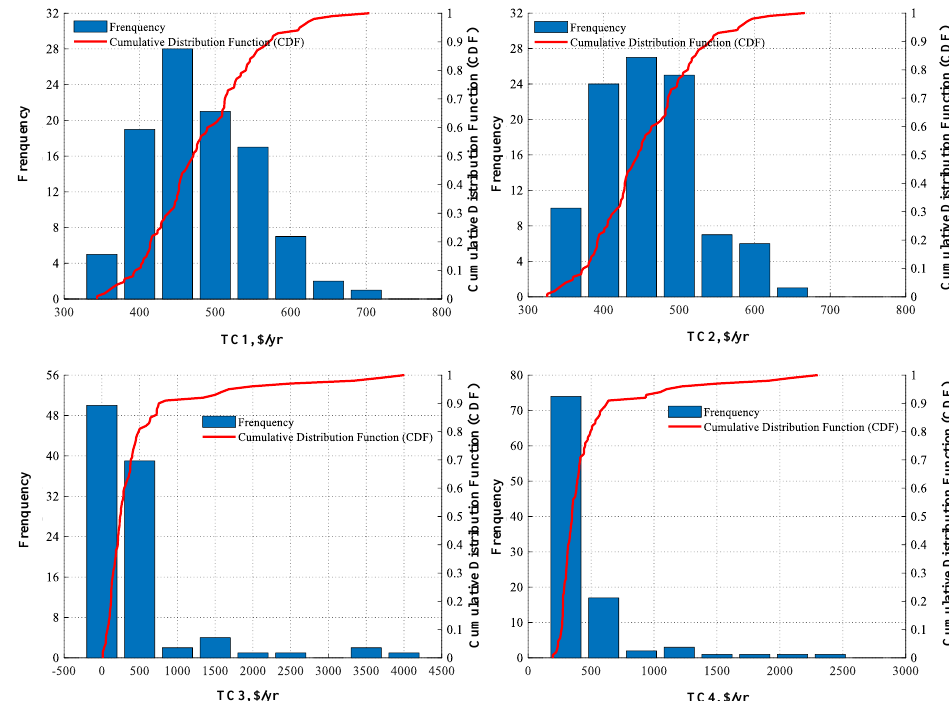
Fig. 7. The cost allocated for 10 th Building under four cost allocation models TC 1, TC 2, TC 3, TC